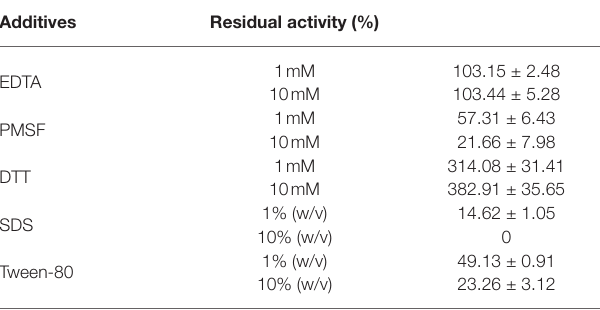
TABLE 1 | Relative activity in the presence of various additives. a